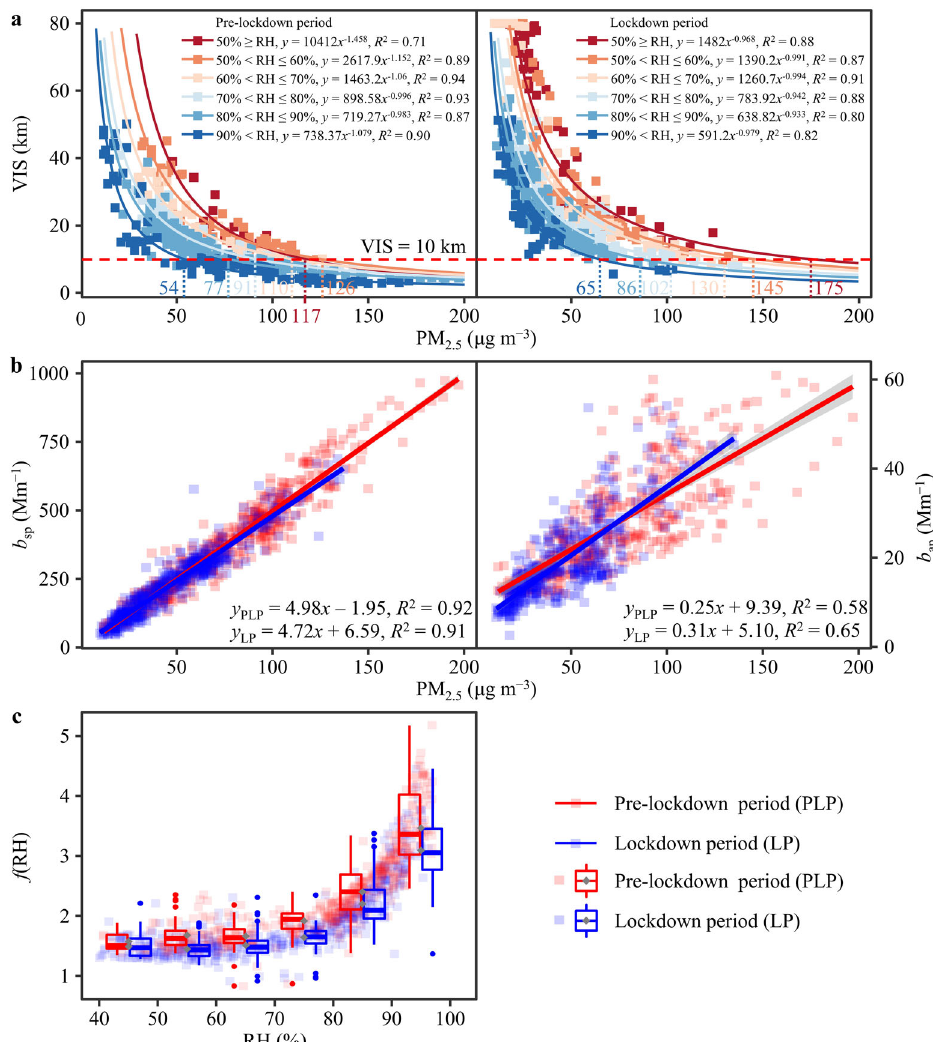
Fig. 2 Drivers for the elevations in PTV 10 . a Scatter plots of ambient visibility (VIS) and PM 2.5 mass concentrations under different relative humidity (RH) ranges. The curves represent the fi tting lines. b Scatter plots of aerosol scattering ( b sp ) and absorption ( b ap ) coef fi cients versus PM 2.5 mass concentrations. The gray zones represent the 95% con fi dence intervals. c Relationships between the optical hygroscopicity ( f (RH)) of PM 2.5 and RH. The upper and lower boundaries of boxes ( c ) represent the 75th and 25th percentiles, respectively; the lines with the boxes mark the median; the whiskers above and below boxes indicate the maximum and minimum values, respectively; the diamonds along the boxes represent the average values; the dots indicate the potential